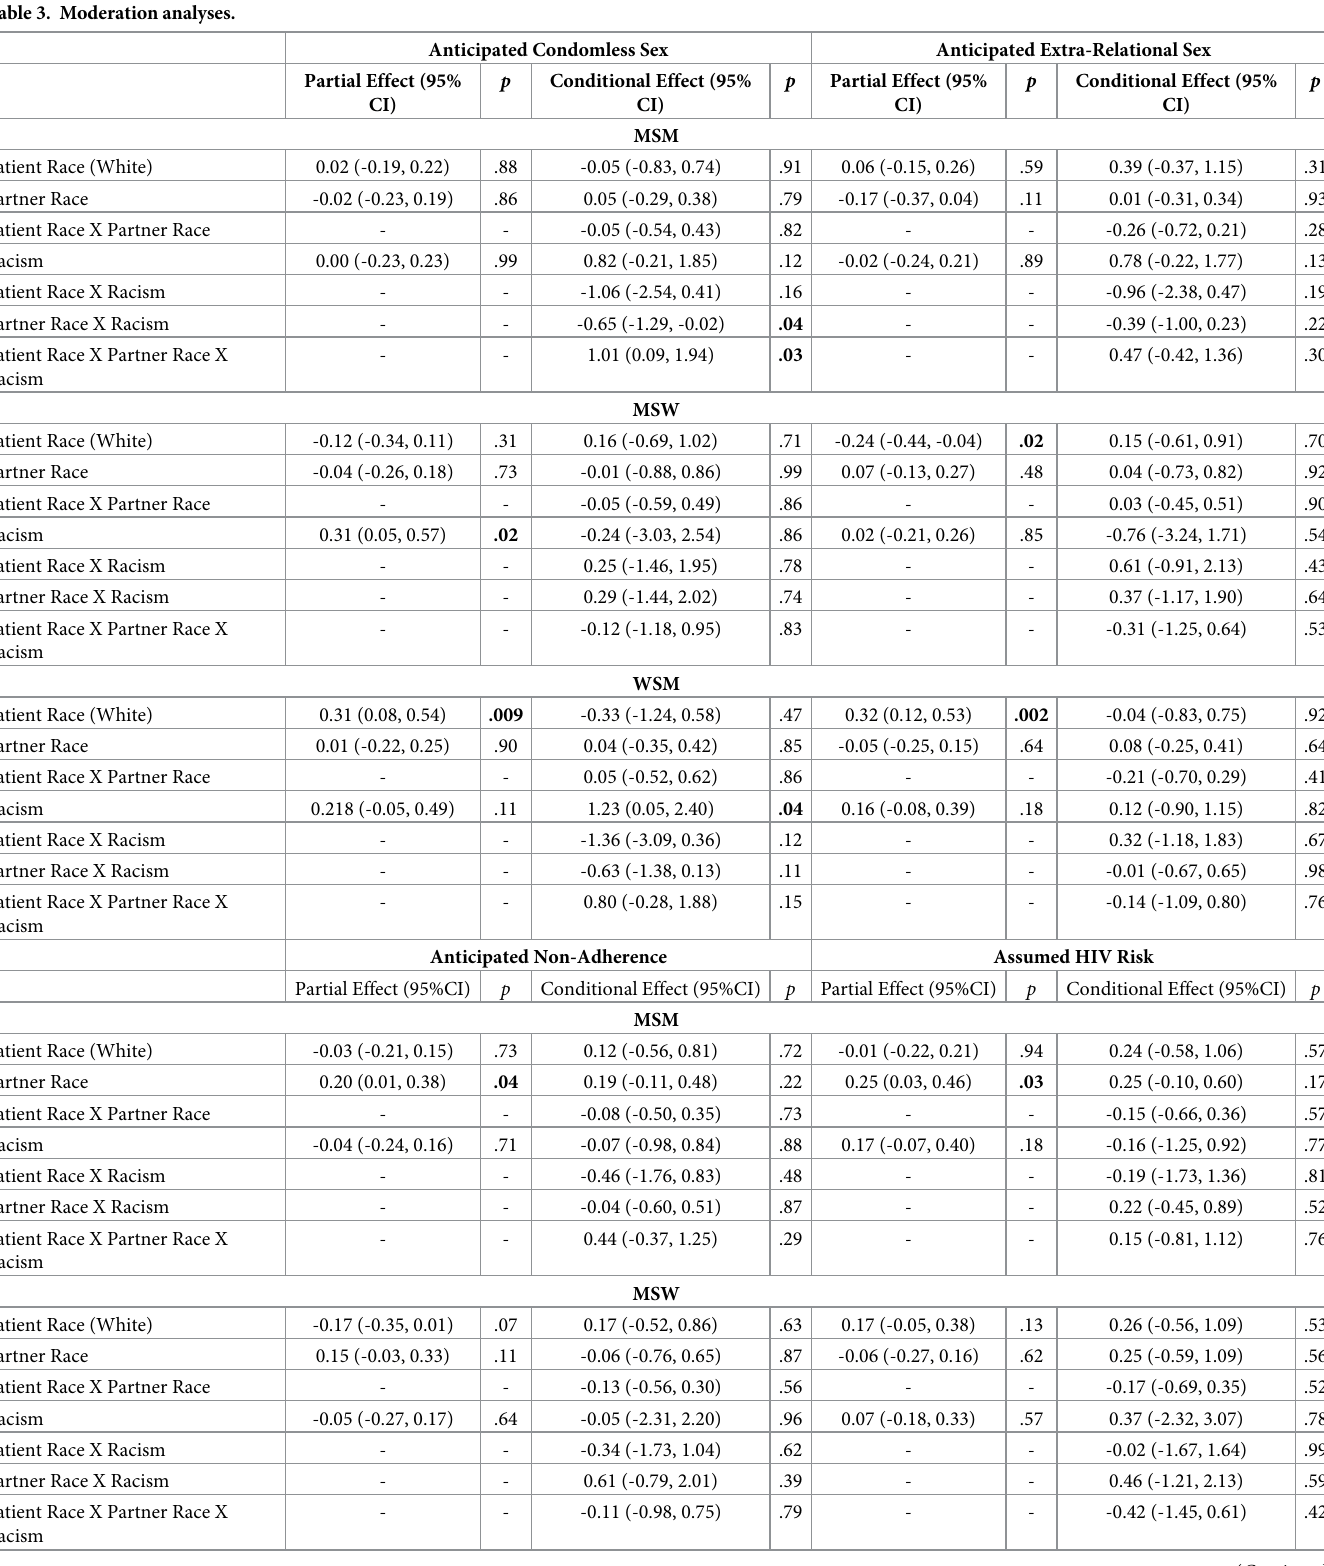
Table 3. Moderation